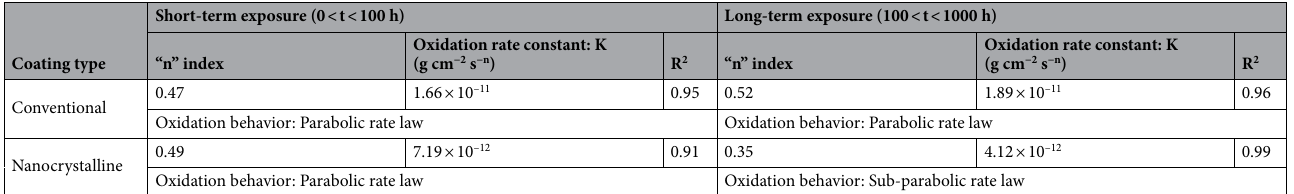
Table 4. Oxidation rate constants (K) and “n” indexes of the as-received and nanocrystalline MCrAlY coatings under short- and long-term oxidation